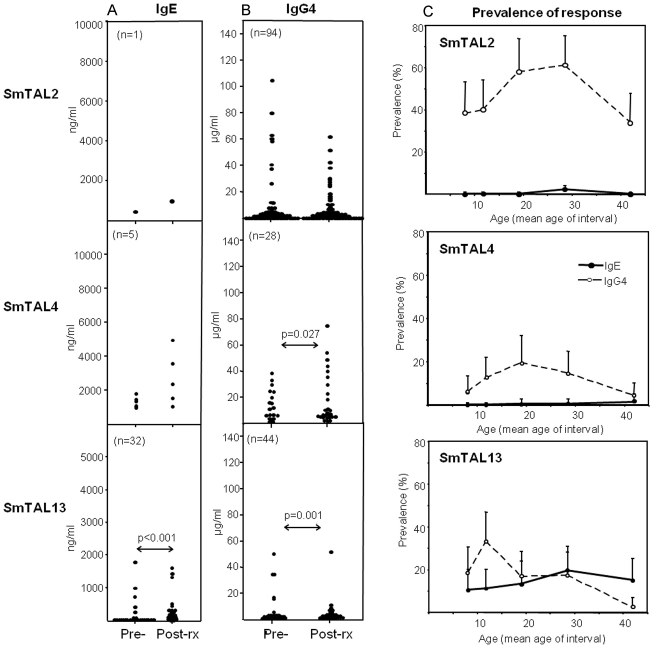
Antibody responses to SmTAL2, SmTAL4 and SmTAL13 in the S. mansoni infected cohort.Recombinant antigens were used in ELISA to measure IgE (A) or IgG4 (B) before and after treatment in infected cohort. Only individuals whose levels exceeded the seropositive threshold (mean+3xSD uninfected controls) for each response are graphed. The prevalence of each response (C) is shown (% seropositive for each group after treatment +95% confidence intervals).